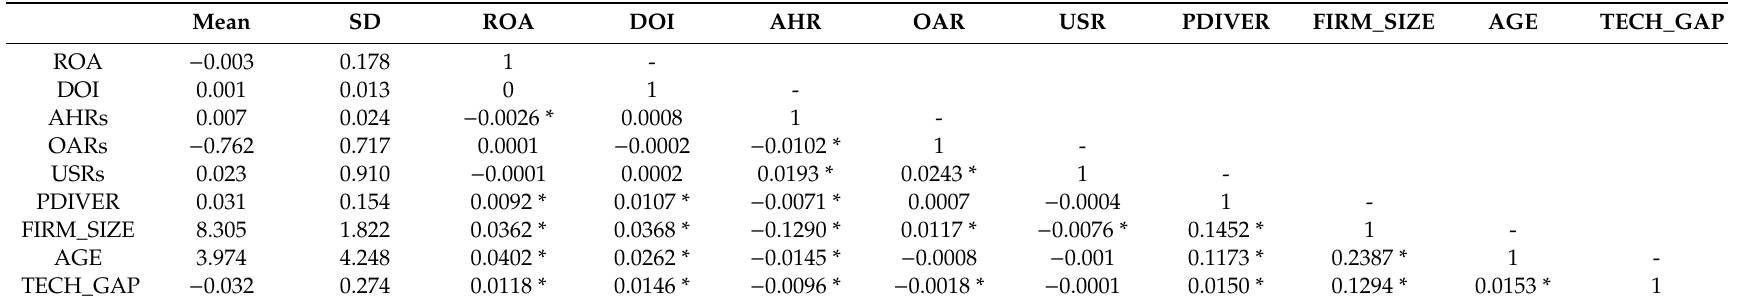
Table 2. Descriptive statistics and variable